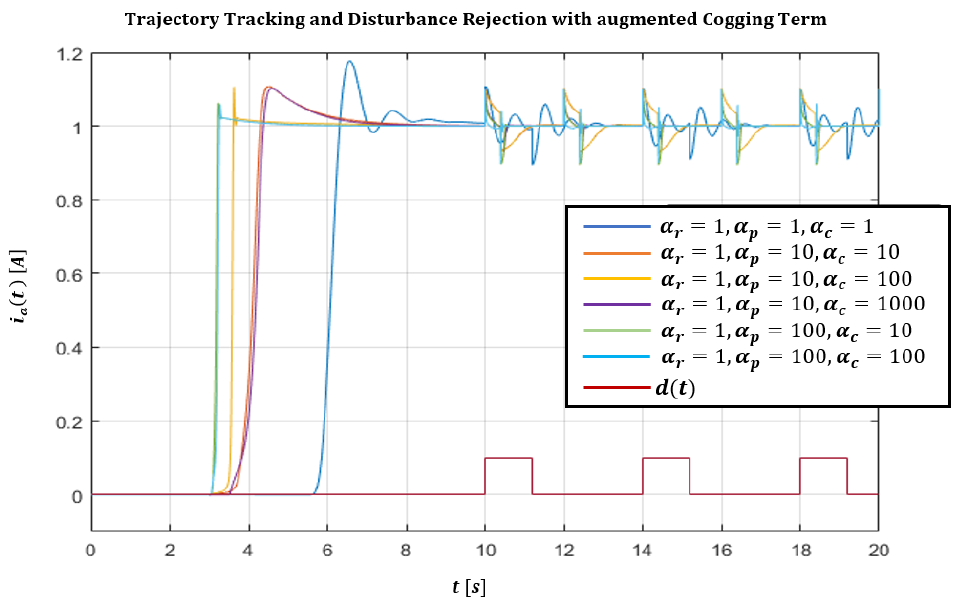
Figure 12. Trajectory Tracking and disturbance rejection with a higher intensity of Cogging Torque effect.